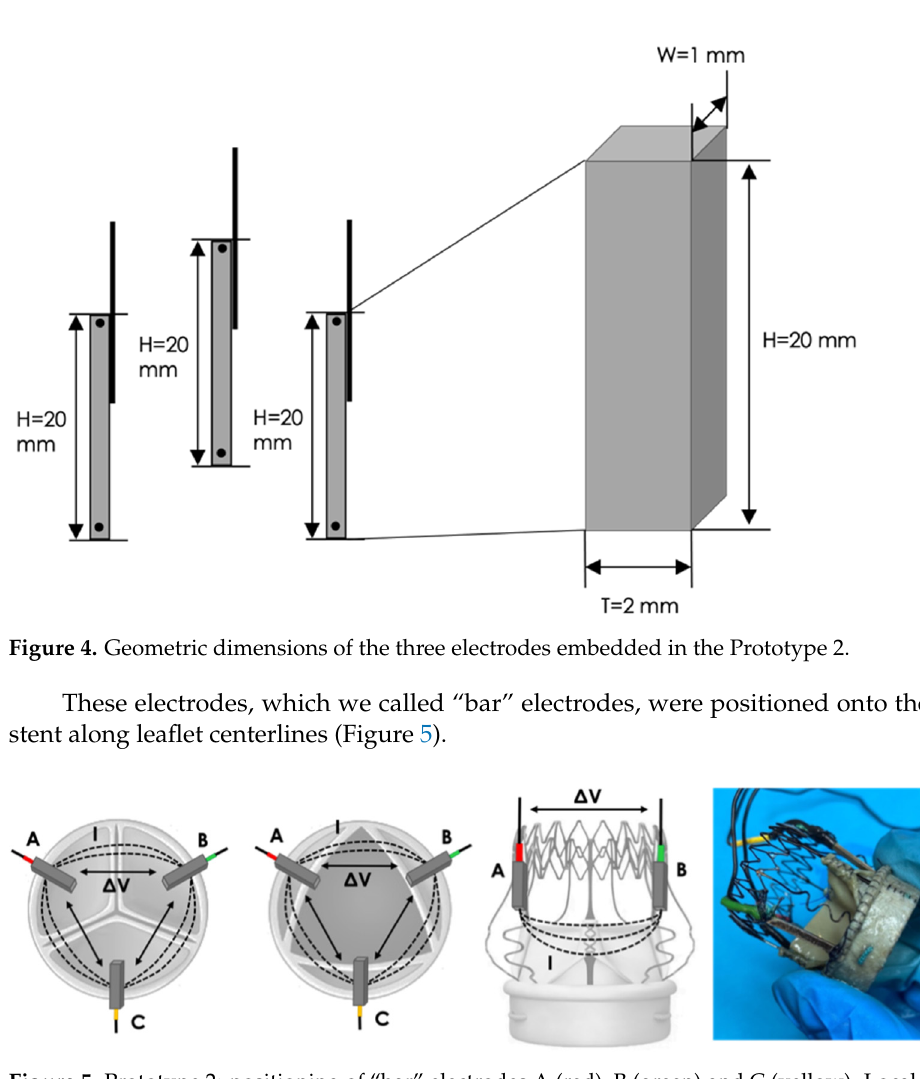
Figure 6. Geometric dimensions of the three electrodes embedded in the Prototype 3.